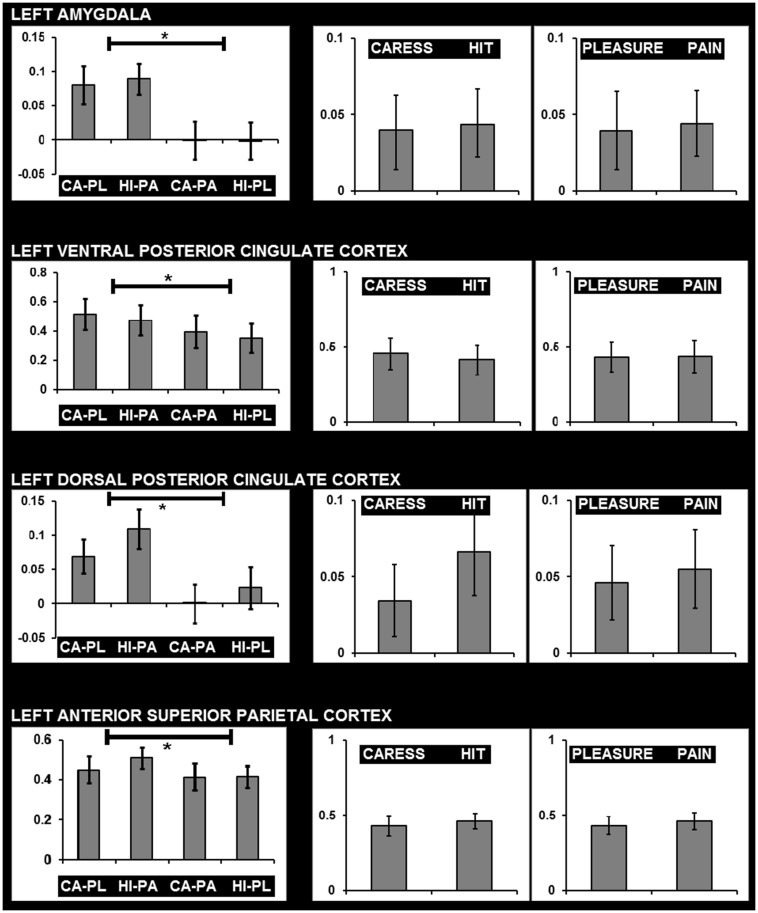
Graphs showing average beta values and standard errors for the experimental conditions regarding voxels clusters characterized by a significant facial expression × tactile sensation interaction effect, and the absence of significant effects due tactile sensation or facial expression separately. Graphs on the left show beta values for the four conditions (CA-PL: caress-pleasure; HI-PA: hit-pain; CA-PA: caress-pain; HI-PL: hit-pleasure) indicating stronger responses for congruent compared to incongruent stimuli. Graphs on the right show average beta values for caress versus hit stimuli, and pleasure versus pain stimuli, illustrating the absence of differences between the observation of distinct tactile sensations or distinct facial expressions in these regions. ∗, statistically significant difference p < 0.05.